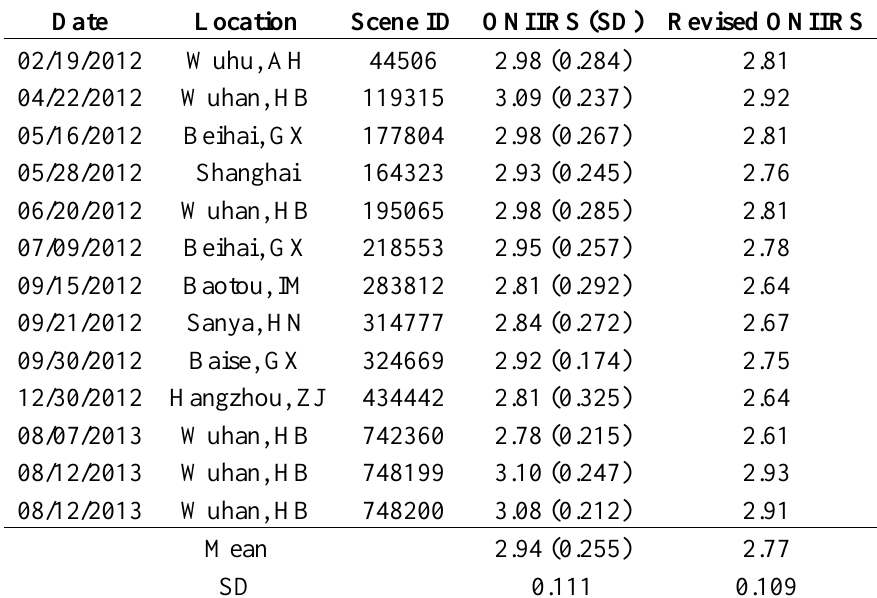
Table 4. Results of the observed NIIRS